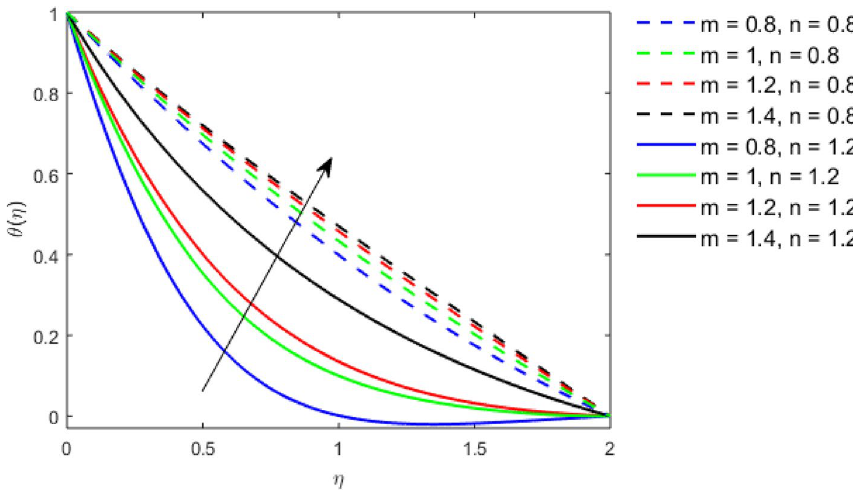
Figure 9. Thermal profile for increasing thickness index m of disk for Pseudoplastic and dilatant fluid.